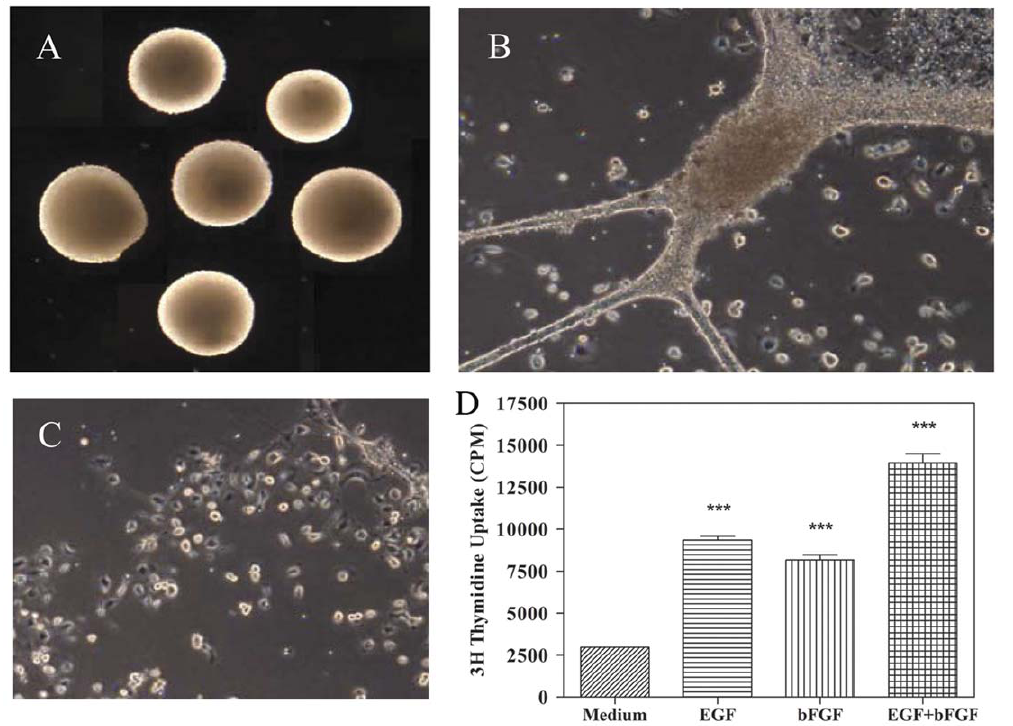
Figure 1. EGF + bFGF induce expansion of NSCs as neurospheres in culture. Brain cells isolated from newborn mice were cultured in 12 well tissue culture plates in NBM + B27 with EGF + bFGF. Neurospheres formed in 7–10 days were photographed under microscope (100 6 ) (A). Neurospheres attach and spread after 10 days in culture (200 6 ) (B). NSCs dissociated from 10 day old neurospheres (200 6 ) (C) were cultured in 96 well tissue culture plates (1 6 10 4 /0.2 ml/well) and the proliferation was measured by 3 H thymidine uptake assay (D). Values are means of triplicates 6 SD and the p values are expressed as *(p , 0.05), **(p , 0.01) and ***(p , 0.001). The figure is a representative of three independent